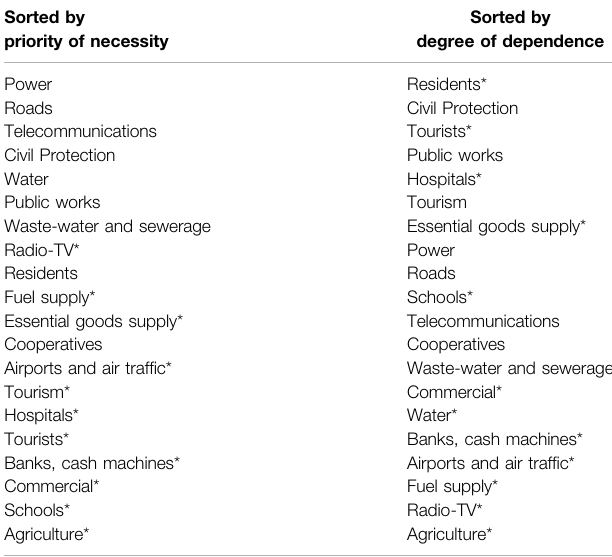
TABLE 4 | Degree of dependence and necessity across systems. Lists sorted from most to least critical (left column) and dependent (right column). Sorted by priority of necessity